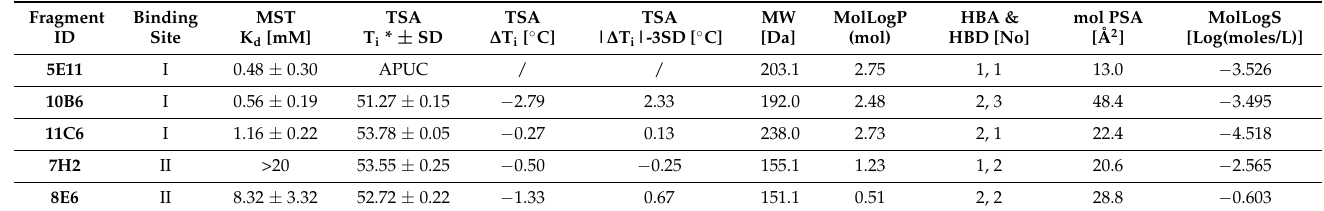
Table 3. Summary of X-ray crystallography, MST and TSA results for fragment hits targeting SARS- CoV-2 nsp1 10-126 and selected calculated properties. The ∆ T i values of SARS-CoV-2 nsp1 10-126 in the presence of fragments obtained from nanoscale differential scanning fluorimetry (nanoDSF) and fragment affinities for SARS-CoV-2 nsp1 10-126 determined by MST are shown. TSA and MST experiments were conducted at least in triplicate. The T i of SARS-CoV-2 nsp1 10-126 in the presence of 2.0% DMSO is 54.05 ◦ C, which was used as a control in ∆ T i calculations. The following chemical